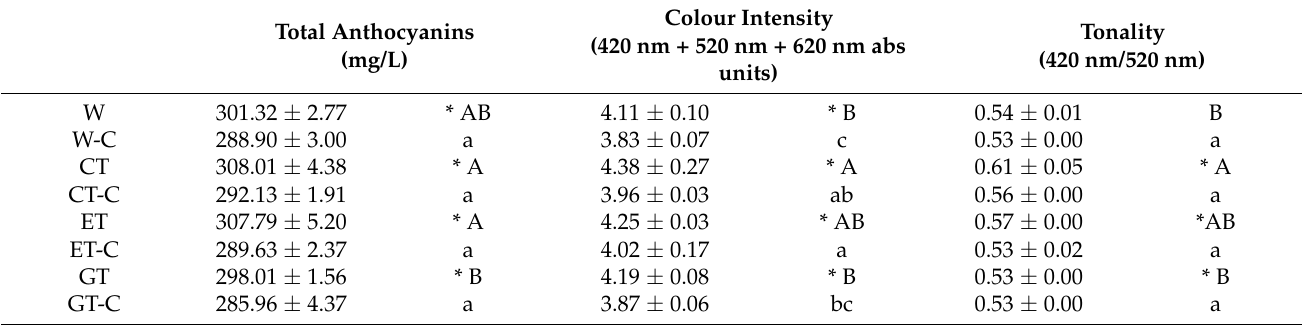
Tonality (420 nm/520 nm)